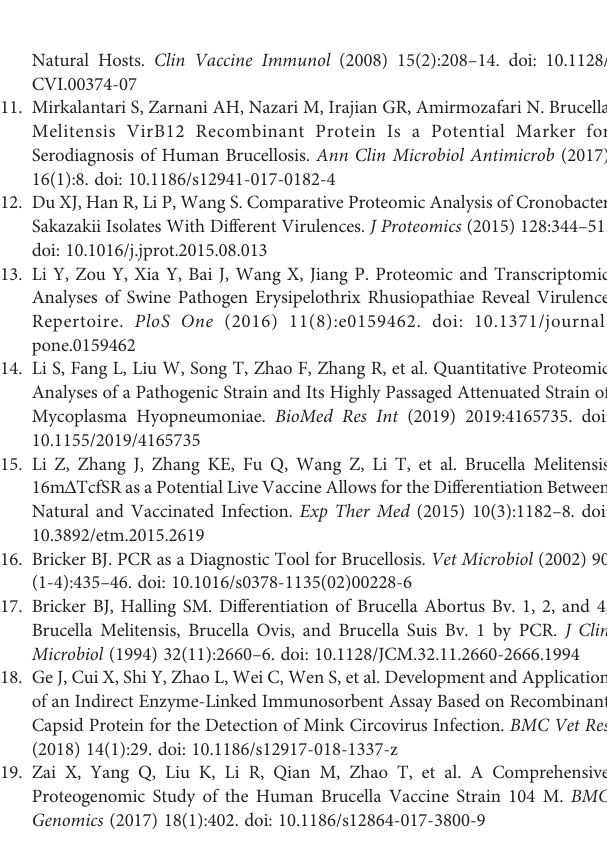
Supplementary Table 2 | Identi fi ed results of mass spectrometry. Supplementary Table 3 | Differentially expressed proteins in the groups of Log w/v and Sta w/v. Supplementary Table 4 | COG analysis for DEPs in the groups of Log w/v and Sta